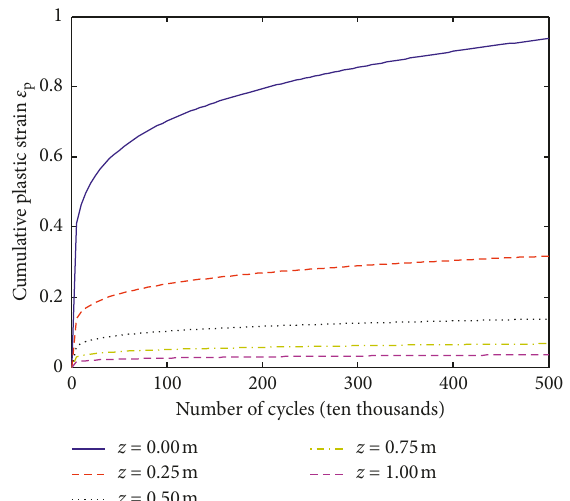
Figure 7: Development of cumulative plastic strain ε number of